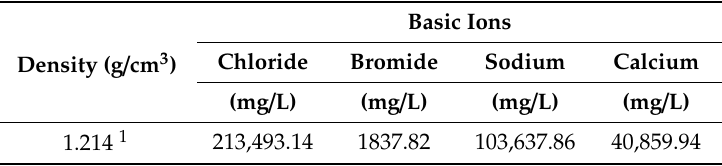
Table 5. Reservoir water